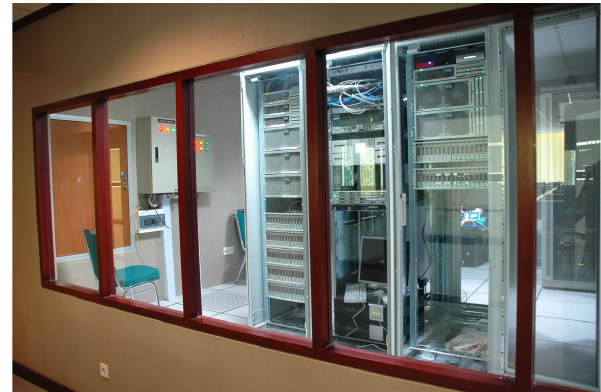
Fig. 16. Local infrastructure in the warning center in Jakarta for the processing systems in the server room.